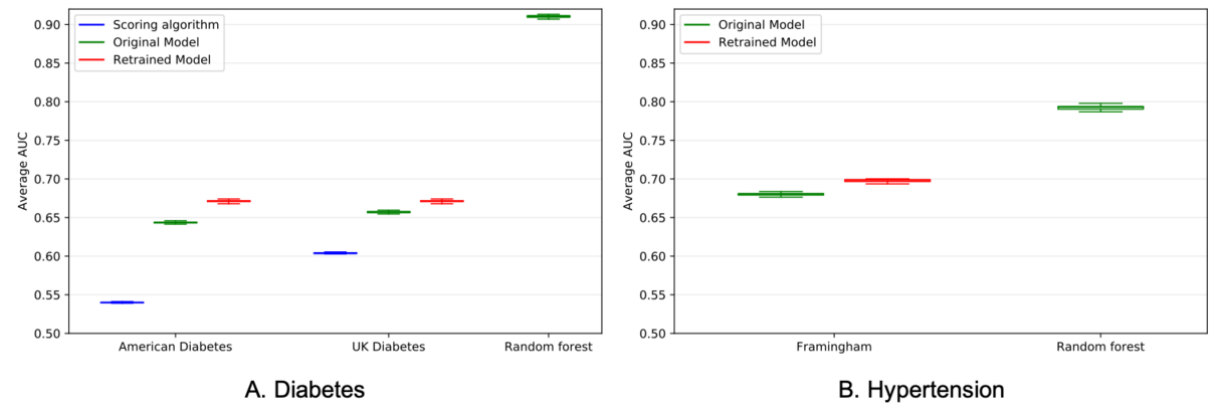
Figure 2. A comparison of the area under curve (AUC) distributions for the random forest model and all baseline approaches. A. For diabetes, the AUC of the random forest model improved upon the best baseline approach (UK diabetes–retrained) by 0.239 (0.910 vs 0.671, P <.001). B. For hypertension, the AUC of the random forest model improved upon the best baseline approach (Framingham-retrained) by 0.095 (0.792 vs 0.697, P